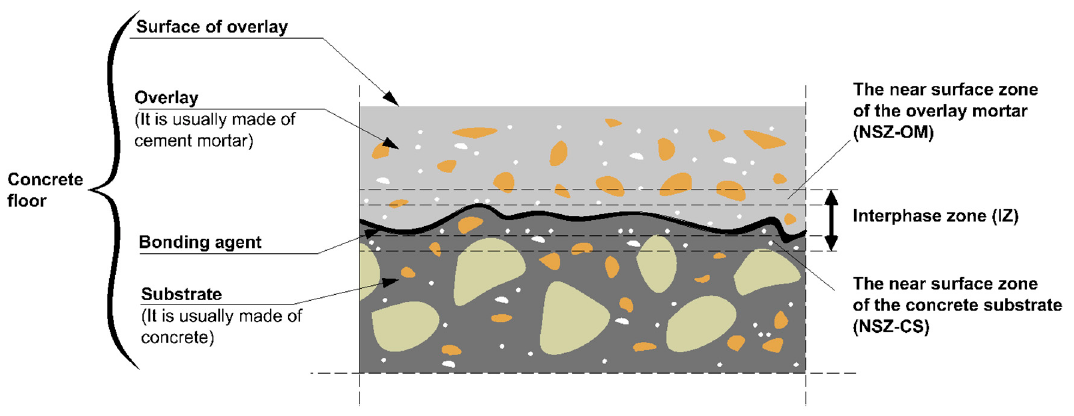
Figure 1. Explanation of basic definitions used in the article.